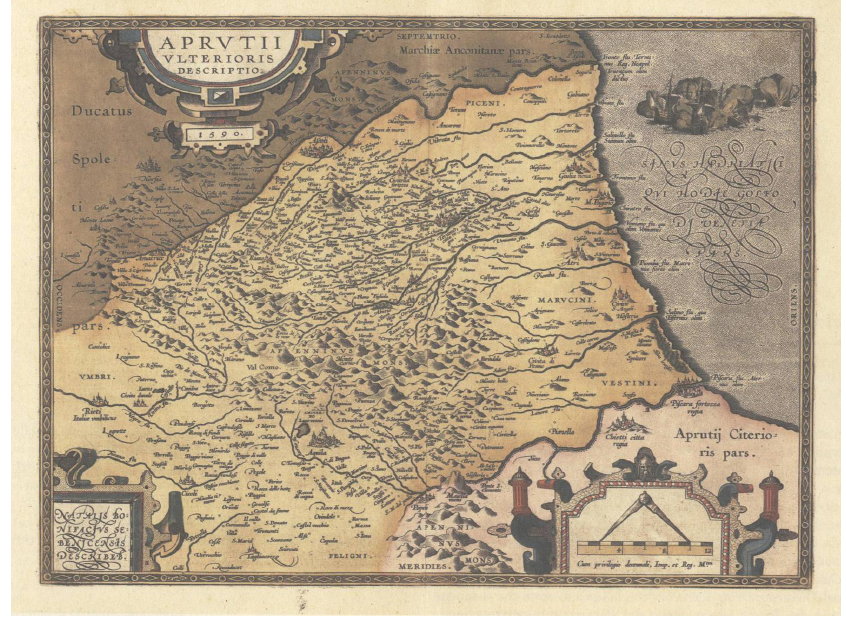
Figure 9. Abramo Ortelio, Aprutii Ulterioris Descriptio , Antwerp (1590), 423 × 326 mm, paper, Archives Collection of Pescara State (R. C.